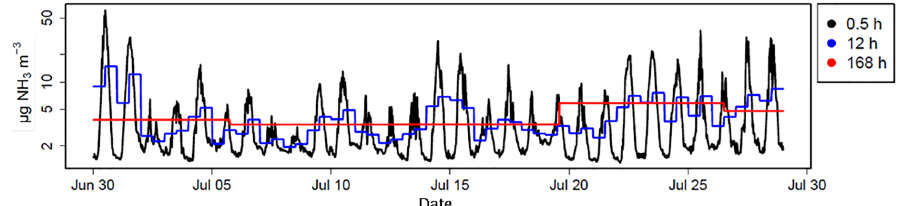
Figure 4. Example modelled concentration pattern at 1m above a single 50m width source for several averaging periods (0.5, 12 and 168h) for the month of July 2008. The source (cid:48) was set to 10 5 . The y axis is log